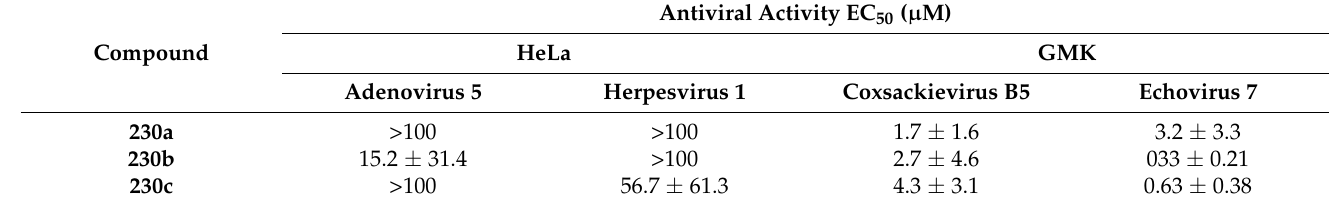
6-(naphthalen-1-yl) nicotinonitrile with POCl 3 and PCl 5 , in a water bath (Figure 25).